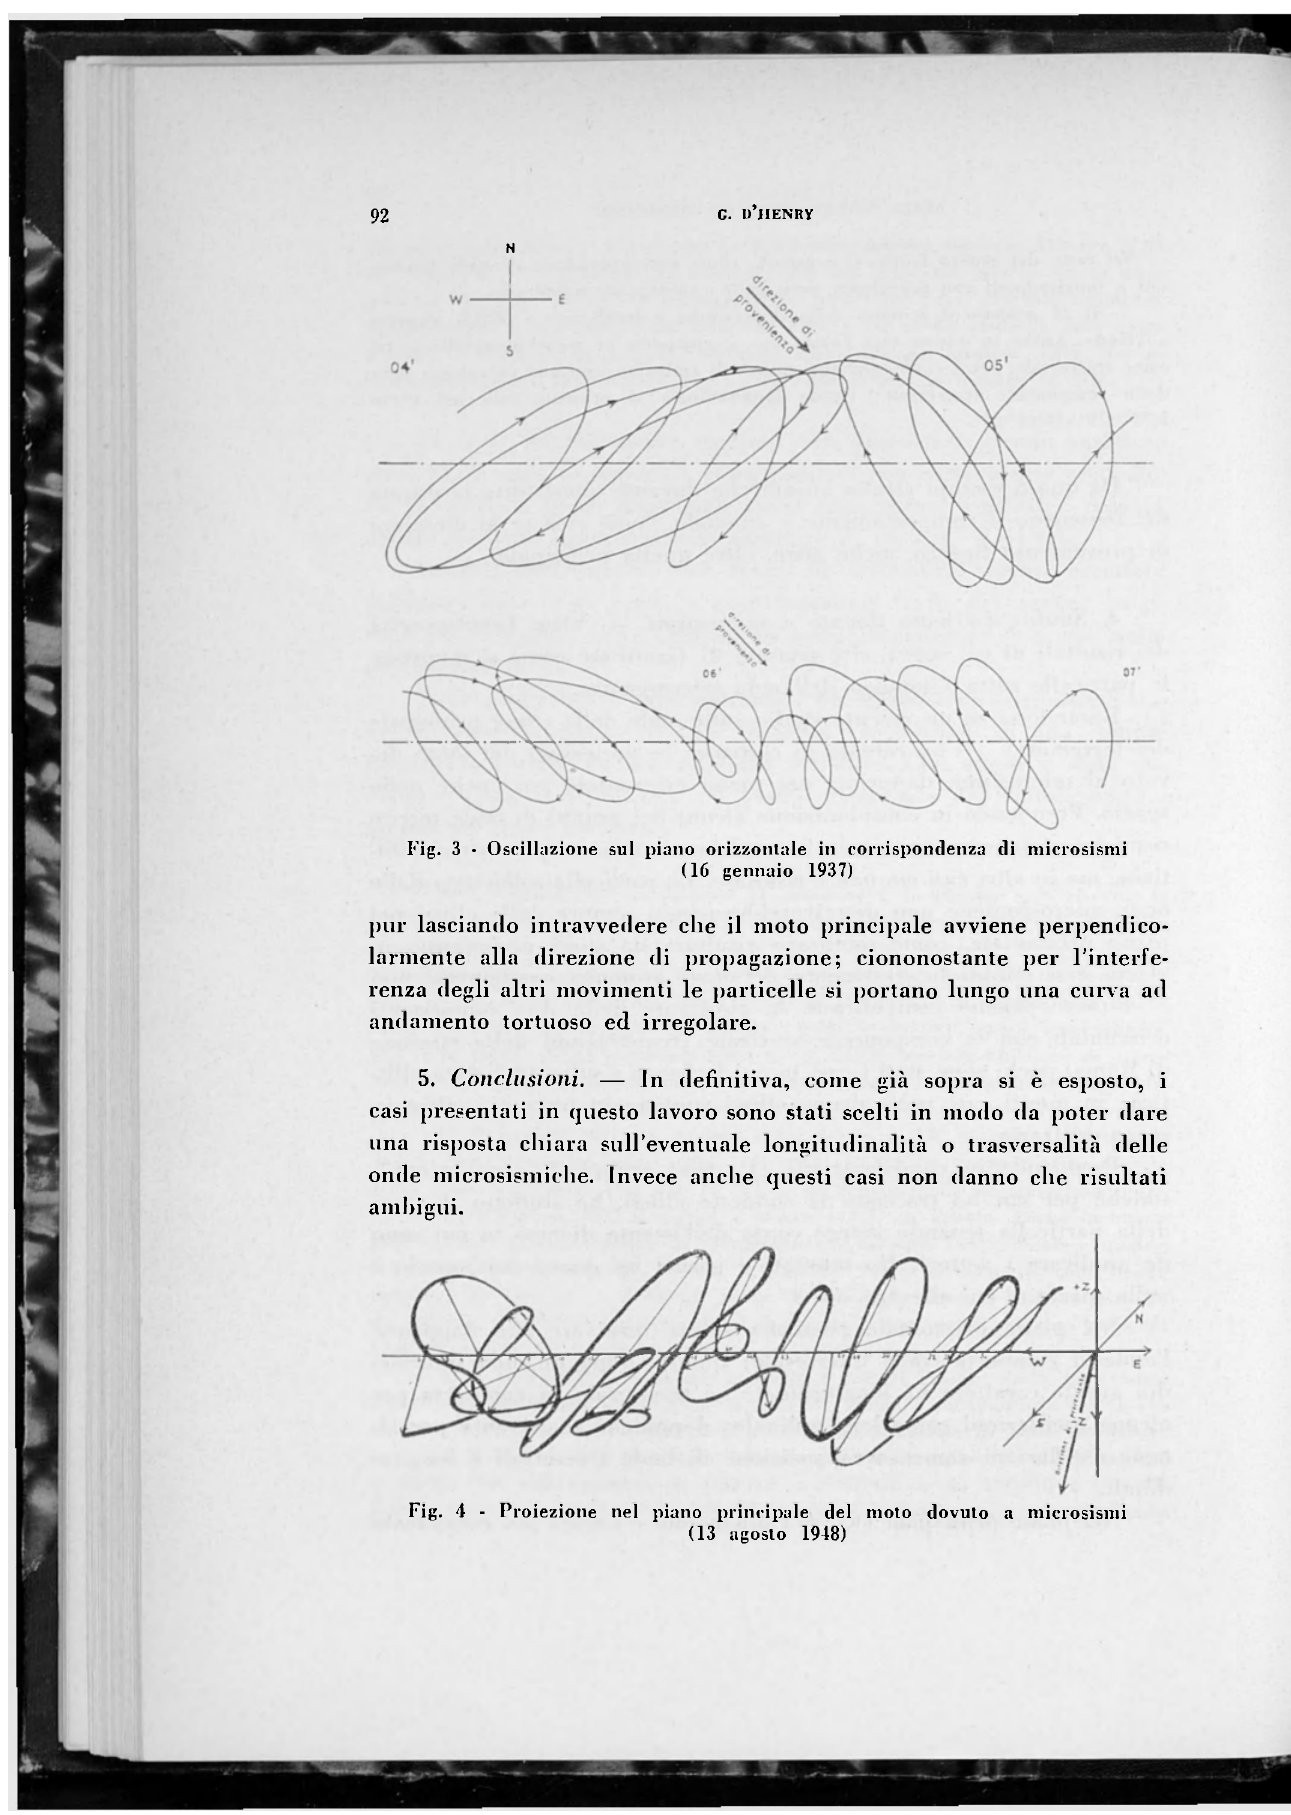
Fig. 4 - Proiezione nel piano principale del moto dovuto a microsismi (13 agosto